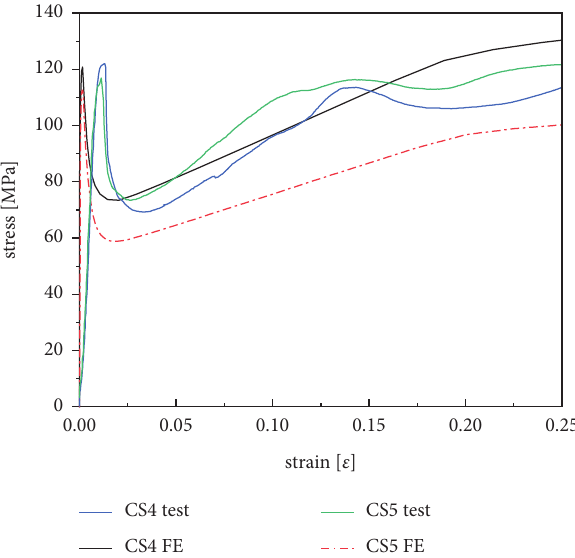
Figure 7: Stress-strain curves of different wall